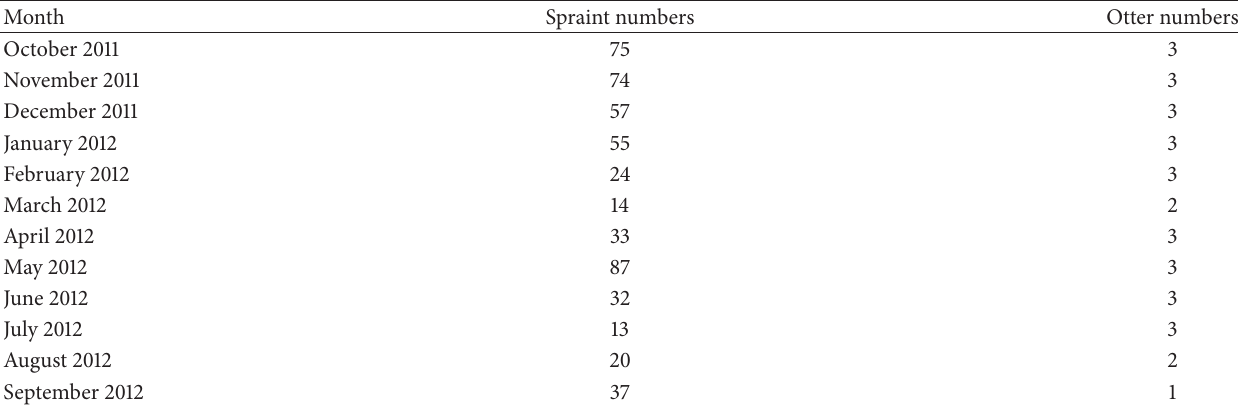
Table 3: Spraint numbers by month on